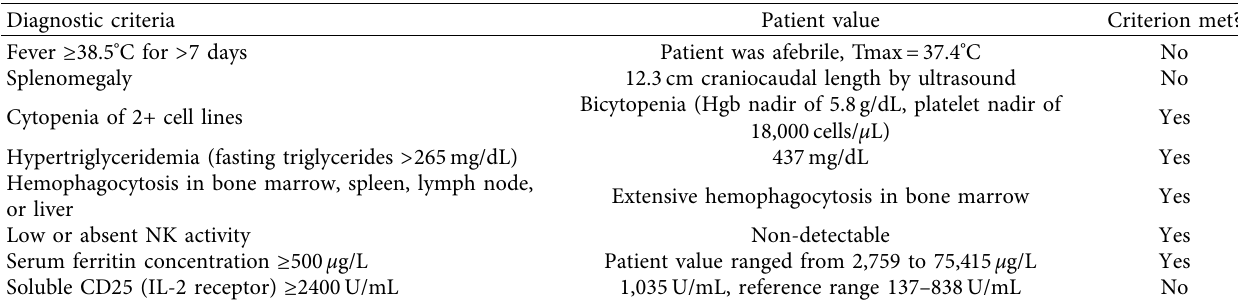
Figure 1: (a) The peripheral blood showed increased nucleated red blood cells with signs of dysplasia (100 × objective), (b) the aspirate smears showed profound dyserythropoeisis (50 × objective), (c) aspirate smears also revealed readily identifiable hemophagocytic cells, consistent with hernophagocytic lymphohistiocytosis (50 × Table 1: Diagnostic criteria for HLH in our patient.